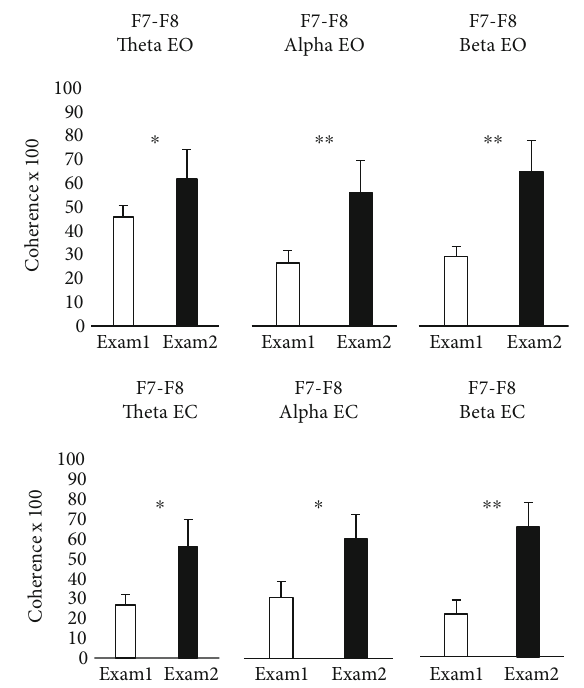
Figure 2: Inferior frontal EEG coherences. Bars show means ± standard errors of theta, alpha, and beta coherences measured from the scalp overlying the inferior frontal cortex (F7-F8), under eyes-open (EO) and eyes-closed (EC) conditions. Subjects were 9 healthy male medical students studied 3 d before each of their fi rst two block exams in an integrated anatomy-physiology course (Exam 1, Exam 2). ∗ indicates di ff erences signi fi cant at P < 0 : 05 , and ∗∗ indicates di ff erences signi fi cant at P < 0 : 01